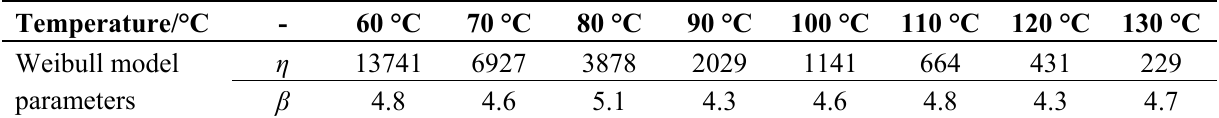
Table 2. Test data and Weibull model parameters at 9.5 kV under different